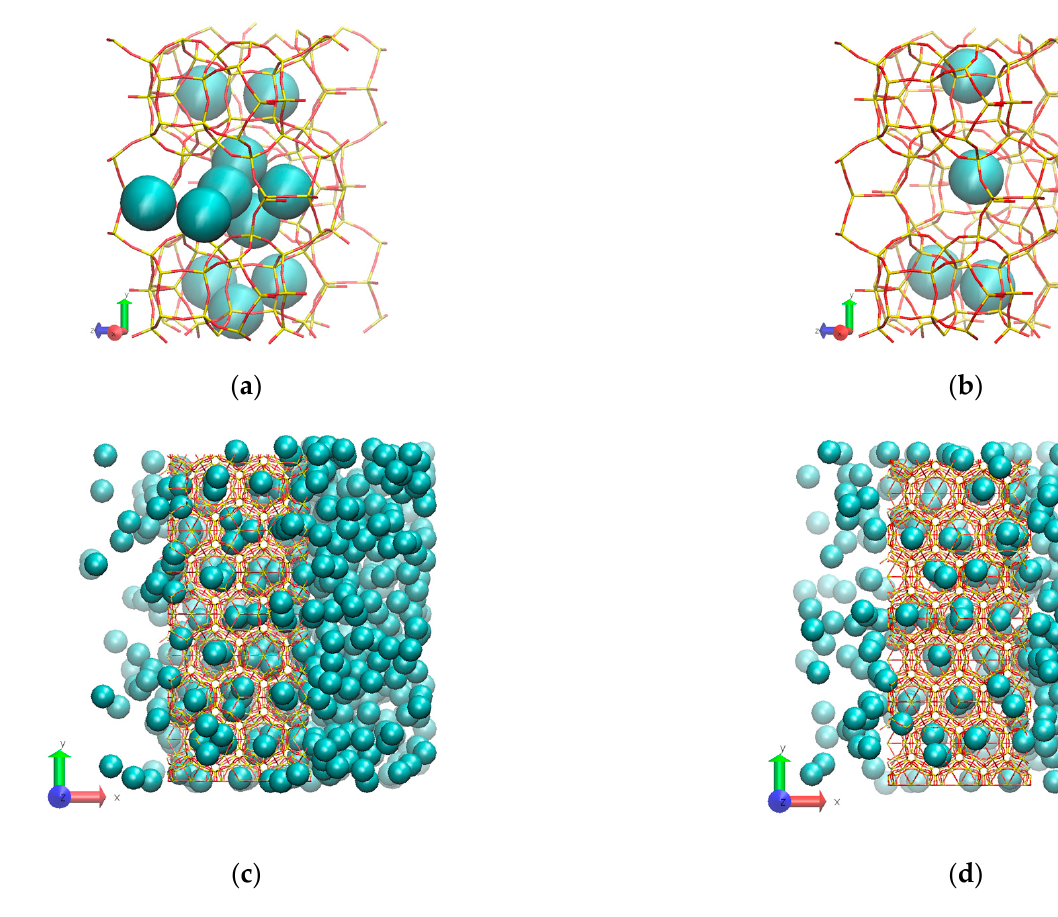
Figure 7. Molecular visualization of the temperature effect: ( a ) (inner cages) 300 K and 150 atm; ( b ) (inner cages) 425 K and 150 atm; ( c ) (overall view) 300 K and 150 atm; ( d ) (overall view) 425 K and 150 atm.